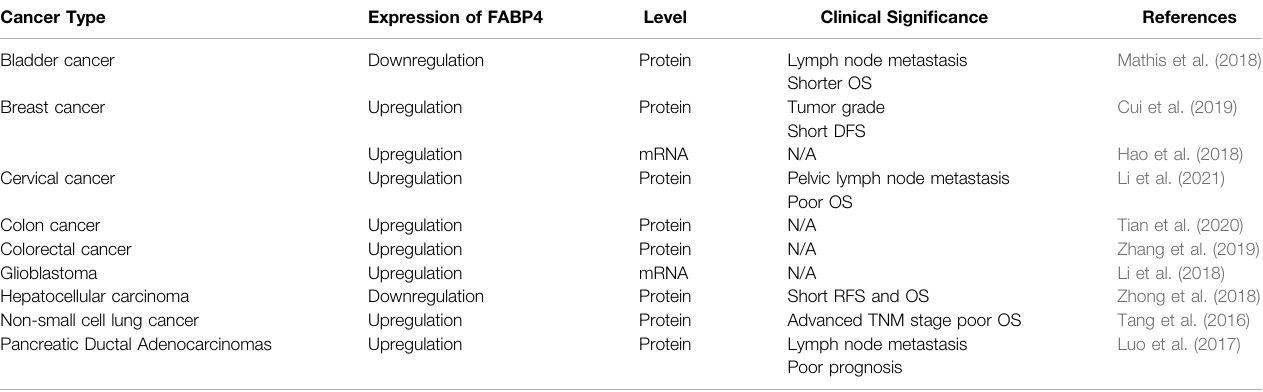
TABLE 1 | Expression patterns and clinical signi fi cance of FABP4 in diverse tumor types.